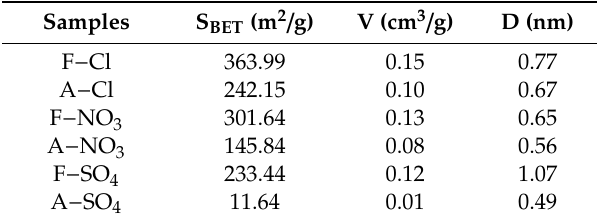
Table 2. Pore structure results of Cu II − SSZ − 13 catalysts before and after hydrothermal aging treatment.